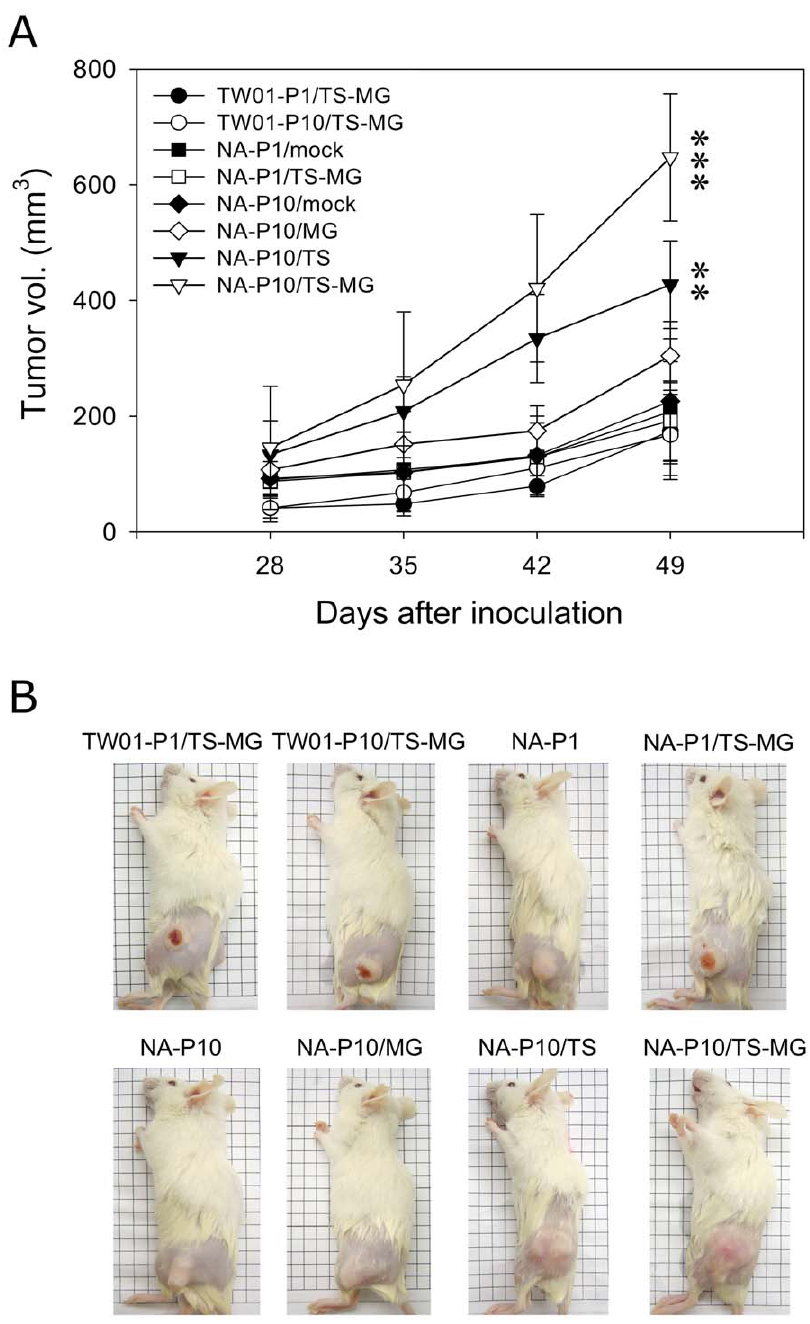
Figure 4. Recurrent EBV reactivations increase the tumorigenicity of NA cells invivo . (A) The tumorigenicity of cells after recurrent EBV reactivation by chemical treatment was evaluated in vivo by injecting cells subcutaneously into SCID mice. The size of the tumors at the inoculation site was measured using a standard procedure at 7-day intervals post-injection. Data indicate mean tumor size ( n $ 8) 6 SD. **: p , 0.01, ***: p , 0.001, when compared to NA-P10/mock cells. (B) Representative photographs of tumor nodules in the mice at day